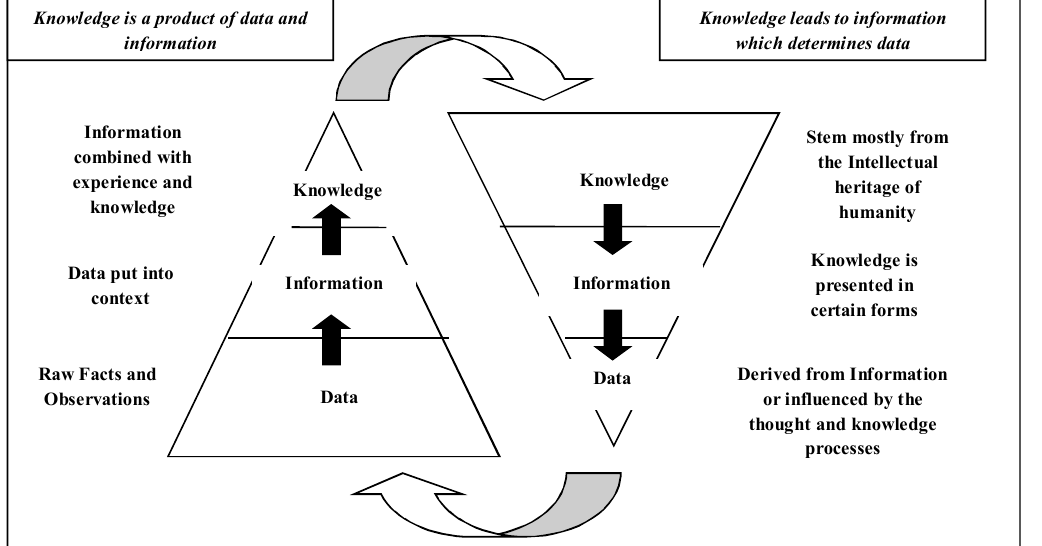
Fig. 1. Hierarchy for Data-Information-Knowledge (Tian et al.,